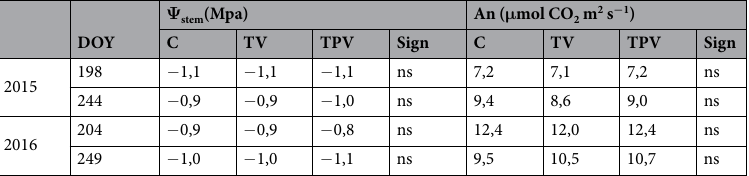
night temperature, T max – T min values in TV were 25 °C and 21 °C in 2015 and 2016 respectively, while in TPV similar values, around 21 °C, were detected in both years. Vine physiological response and berry technological maturity.